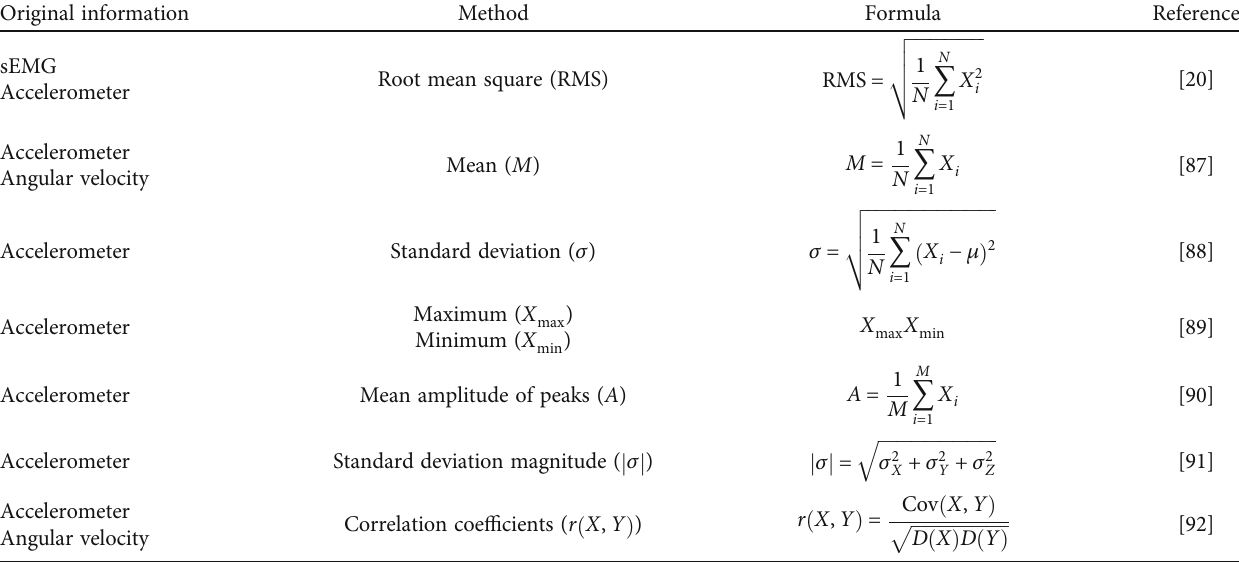
Table 2: Feature-level extraction and